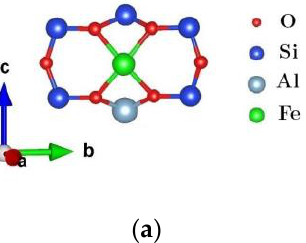
( b ) Figure 4. Minimal energy configurations for sodic mordenite zeolite with a Si/Al = 7 ratio and: ( a ) one Fe atom and ( b ) one Fe and one Cu atom by unit cell. In both cases, the unit cell (delimited by